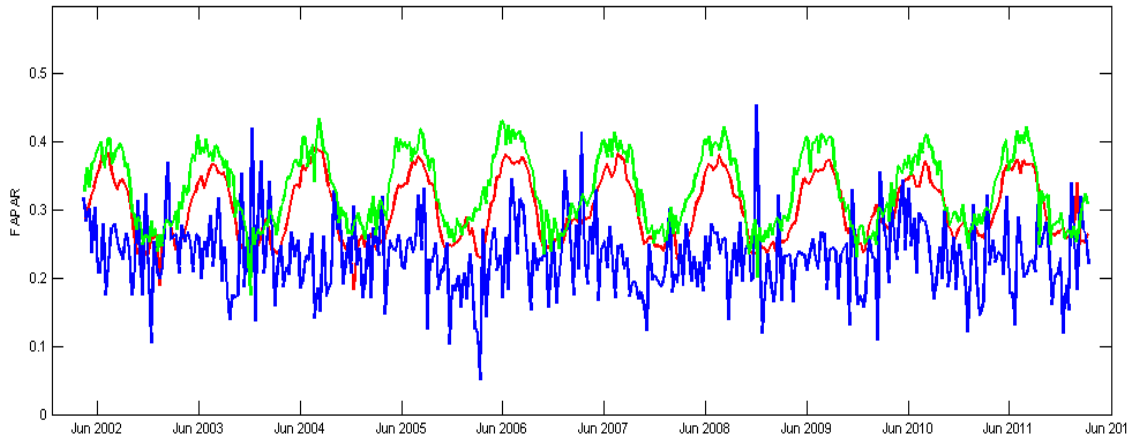
Figure 7. Global average value dynamics of the three products: GEOV1 (red), MGVIo (blue) and MODC5 (green). Products are displayed at their original temporal resolution (Table 2). The 49 × 49 pixel values are averaged over all the BELMANIP2 sites for the period defined in the validation exercise.